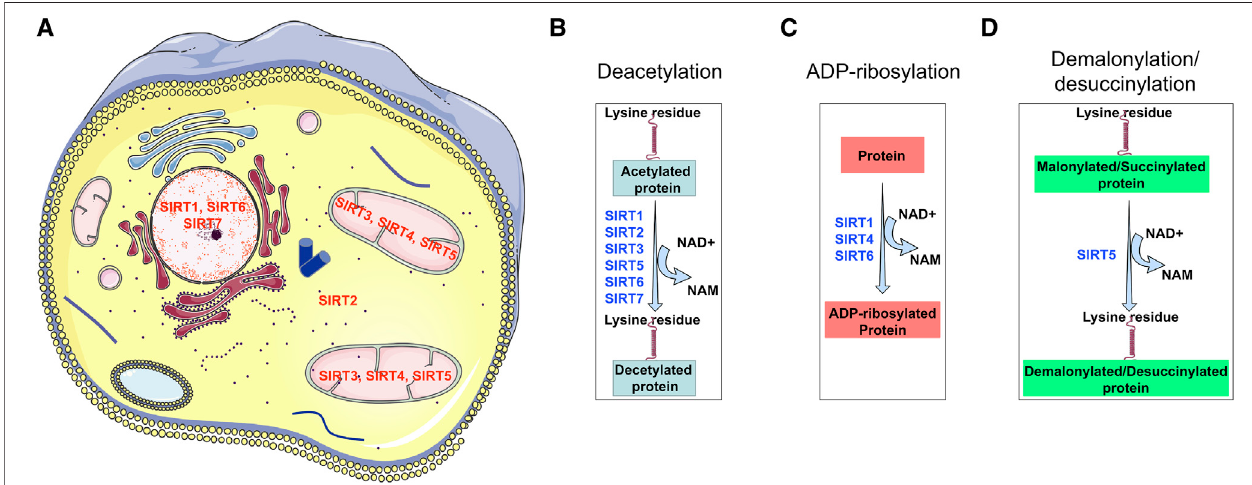
FIGURE 3 | Sub-cellular localization of diverse types of sirtuins and their functionalproperties. SIRT1, SIRT6, and SIRT7 localize in the nucleus; SIRT3, SIRT4, and SIRT5 localize in mitochondrial; however only SIRT4 is known to reside in the cytosol. SIRT1, SIRT2, SIRT3, SIRT4, SIRT5, SIRT6, and SIRT7 have deacetylation properties;SIRT1,SIRT4and,SIRT6 haveADP-ribosylationactivity,however,SIRT5 hastwouniquepropertiesofdemalonylationanddesuccinylation.Thesefunctional differences make each sirtuin of diverse biological importance in renal health.